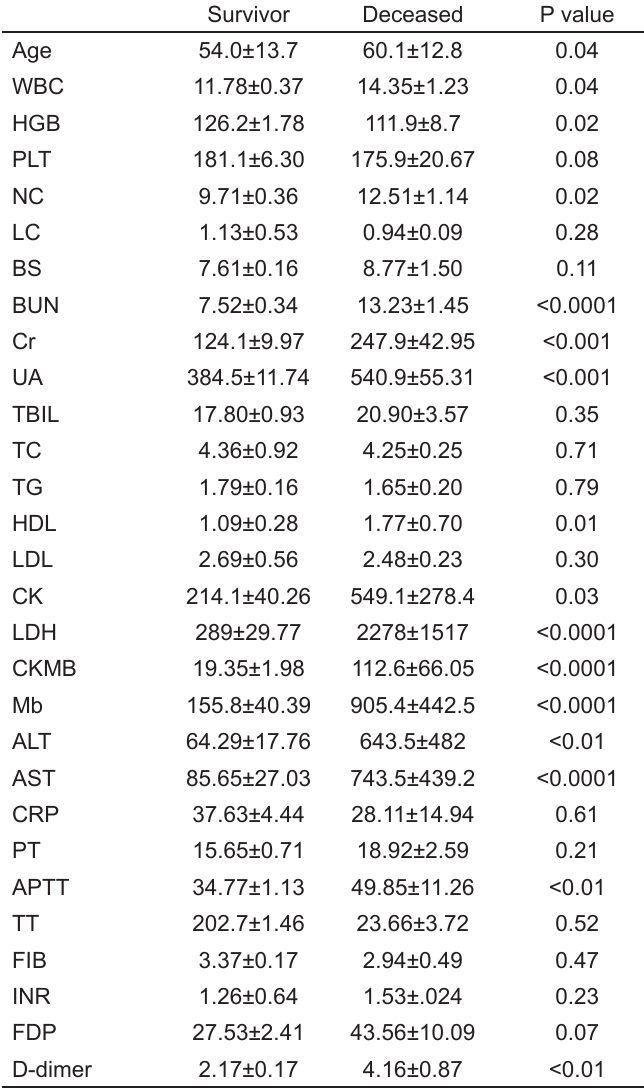
Table 5. The differences between surviving and deceased pa - tients in Type A